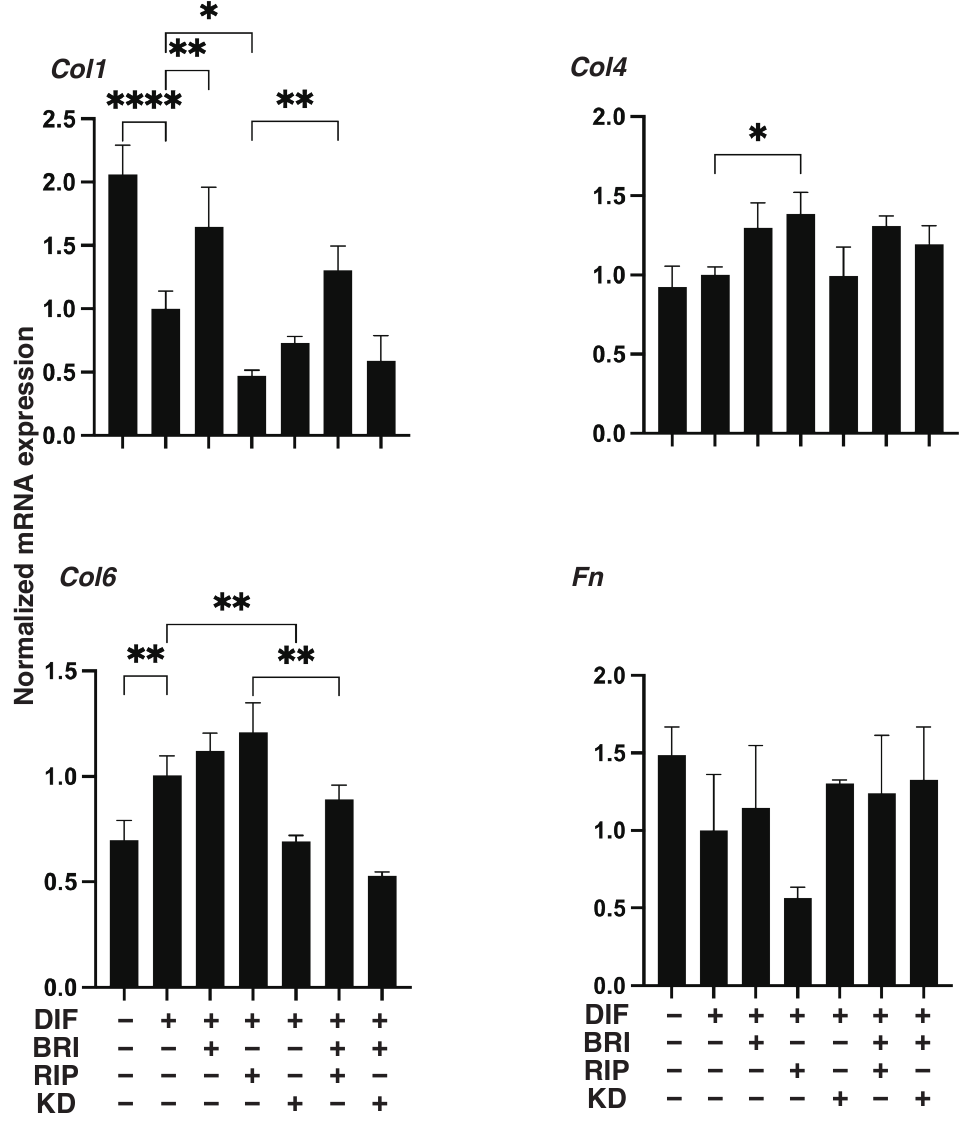
Figure 2. Effects of ROCK-is and/or BRI on ECM expression in 2D cultured 3T3-L1 cells. The 3T3-L1 cells were 2D-cultured under several conditions: preadipocytes of 3T3-L1 cells (DIF−) and their adipogenic differentiation (DIF+) with or without 10 µM ripasudil (Rip) or KD025, and/or BRI were subjected to qPCR analysis to estimate mRNA expression of ECM molecules (Col1: collagen 1, Col4: collagen 4, Col6: collagen 6, Fn: fibronectin). All experiments were performed in triplicate using fresh preparations, each consisting of five samples. Data are presented as the arithmetic mean ± standard error of the mean (SEM). * p < 0.05, ** p < 0.01, **** p < 0.001 ,and other pairs were not statistically significant (ANOVA followed by a Tukey’s multiple comparison test).